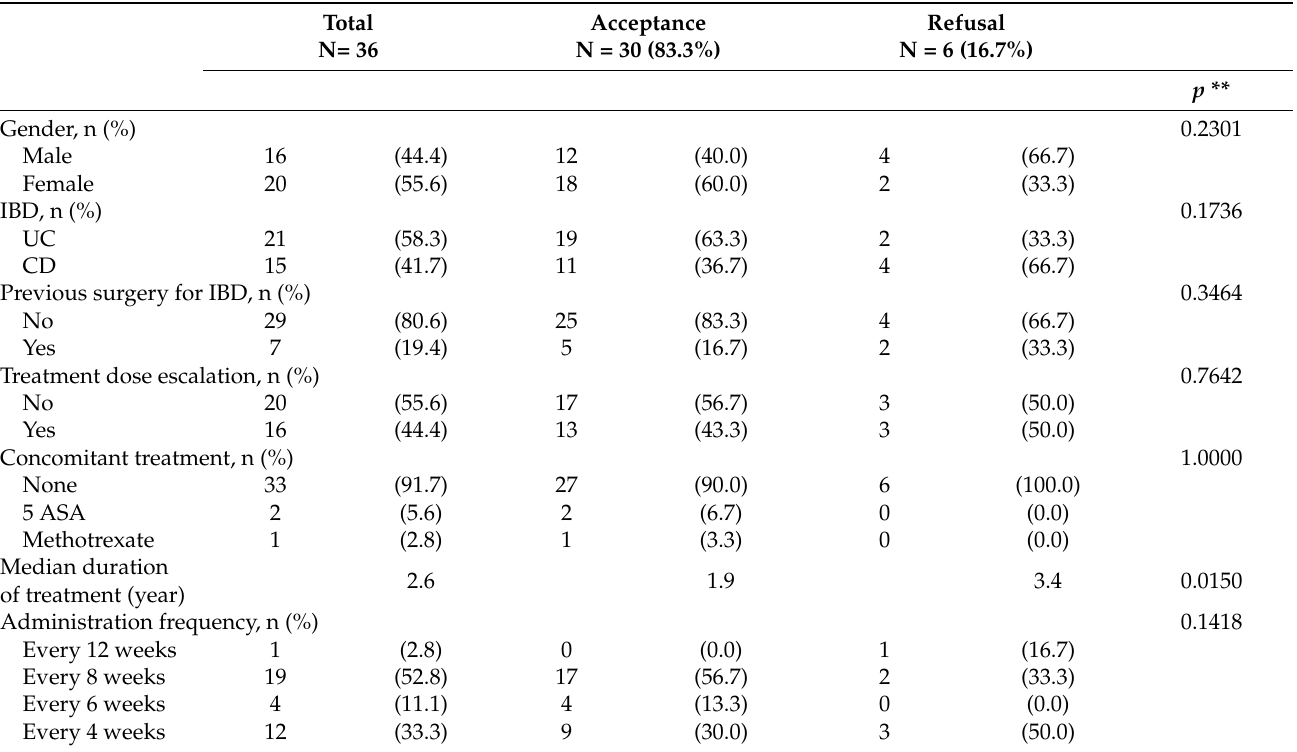
Table 4. Comparison of characteristics of patients treated with vedolizumab according to acceptance or refusal for switching.